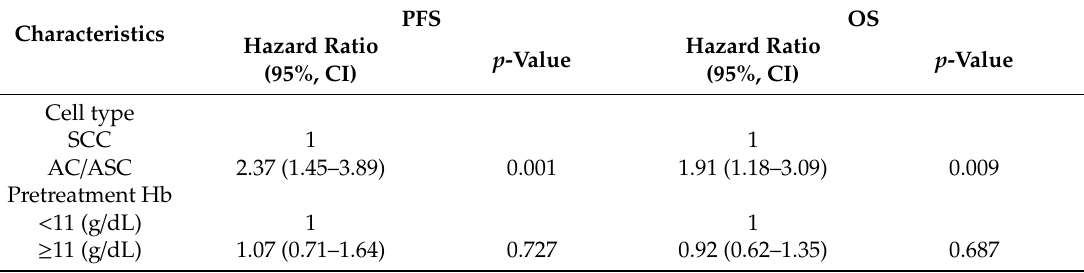
Table 3. Multivariate analysis of prognostic factors for PFS /